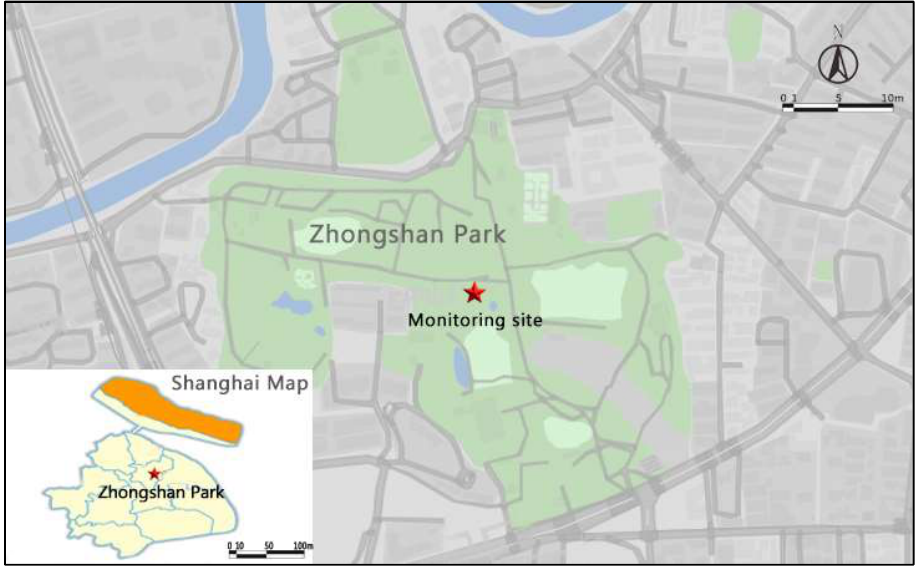
Figure 1. The location of Zhongshan Park and the monitoring site.